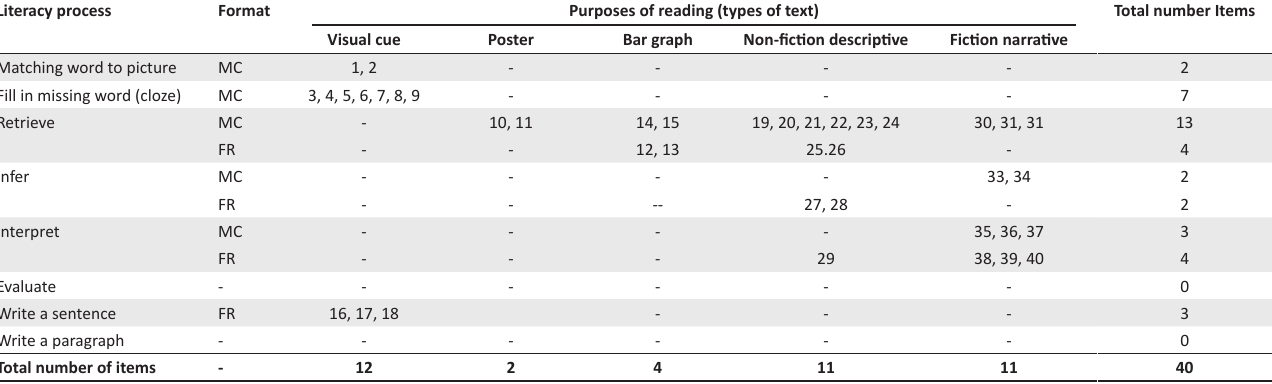
TABLE 5: Distribution of literacy test items in Test 1 and Test 2 according to text type and literacy process. Literacy process Format